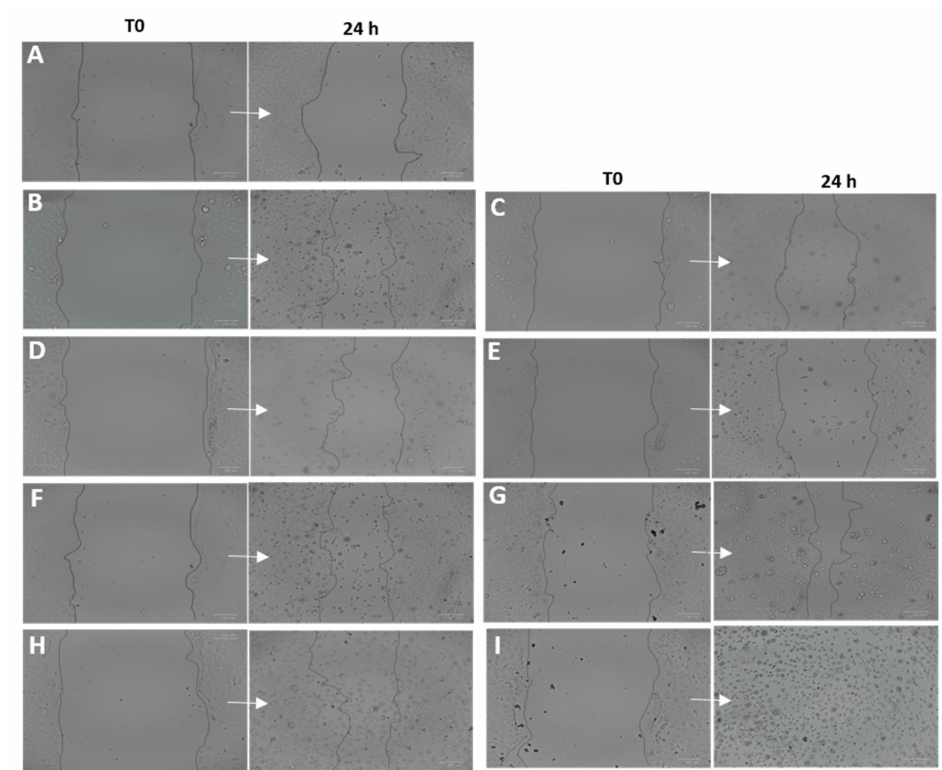
Figure 11. Wound healing activity in HaCaT pre-scratch treatment (wound healing prevention). Scratches were monitored at T0 and after 24 h incubation. ( A ) control, ( B ) Free TH, ( C ) chitosan, ( D ) phosphatidylcholine, ( E ) TH-NP-L-, ( F ) TH-NP-P-, ( G ) TH-NP-P-C+, ( H ) TH-NP-PP- and ( I ) TH-NP-PP-C+.